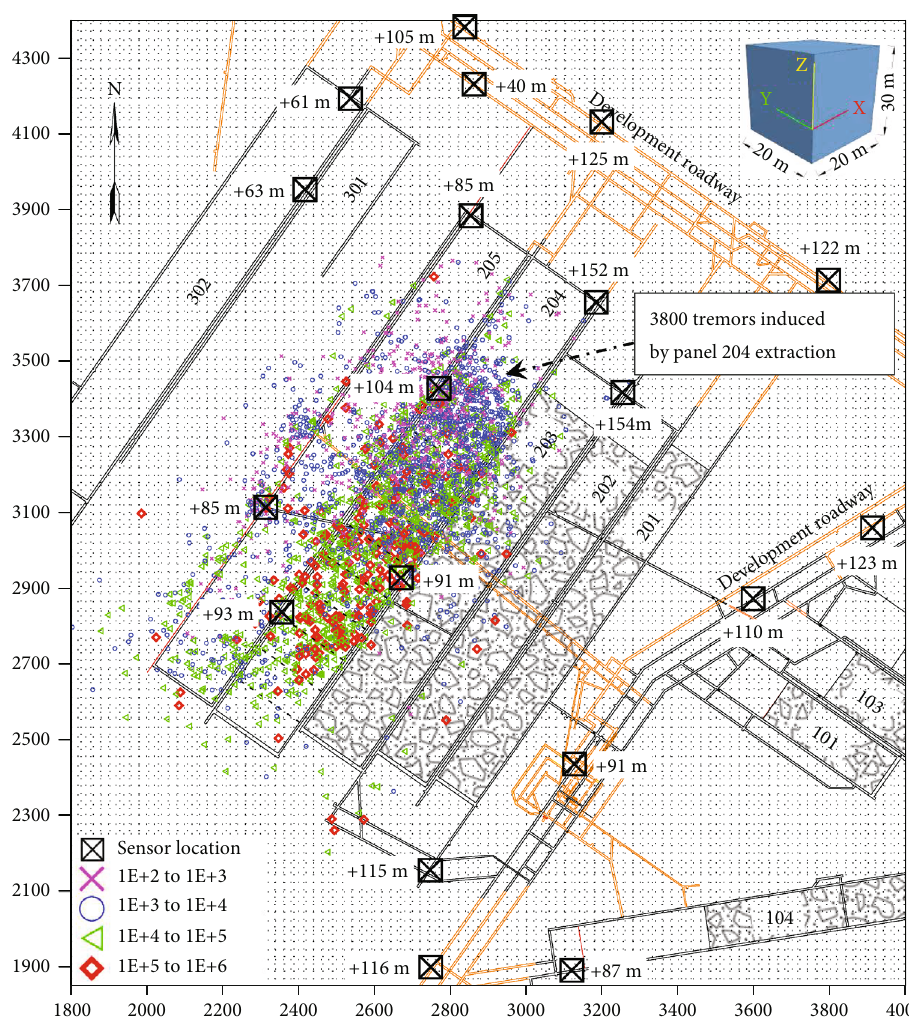
Figure 3: Seismic monitoring network and mining-induced tremors